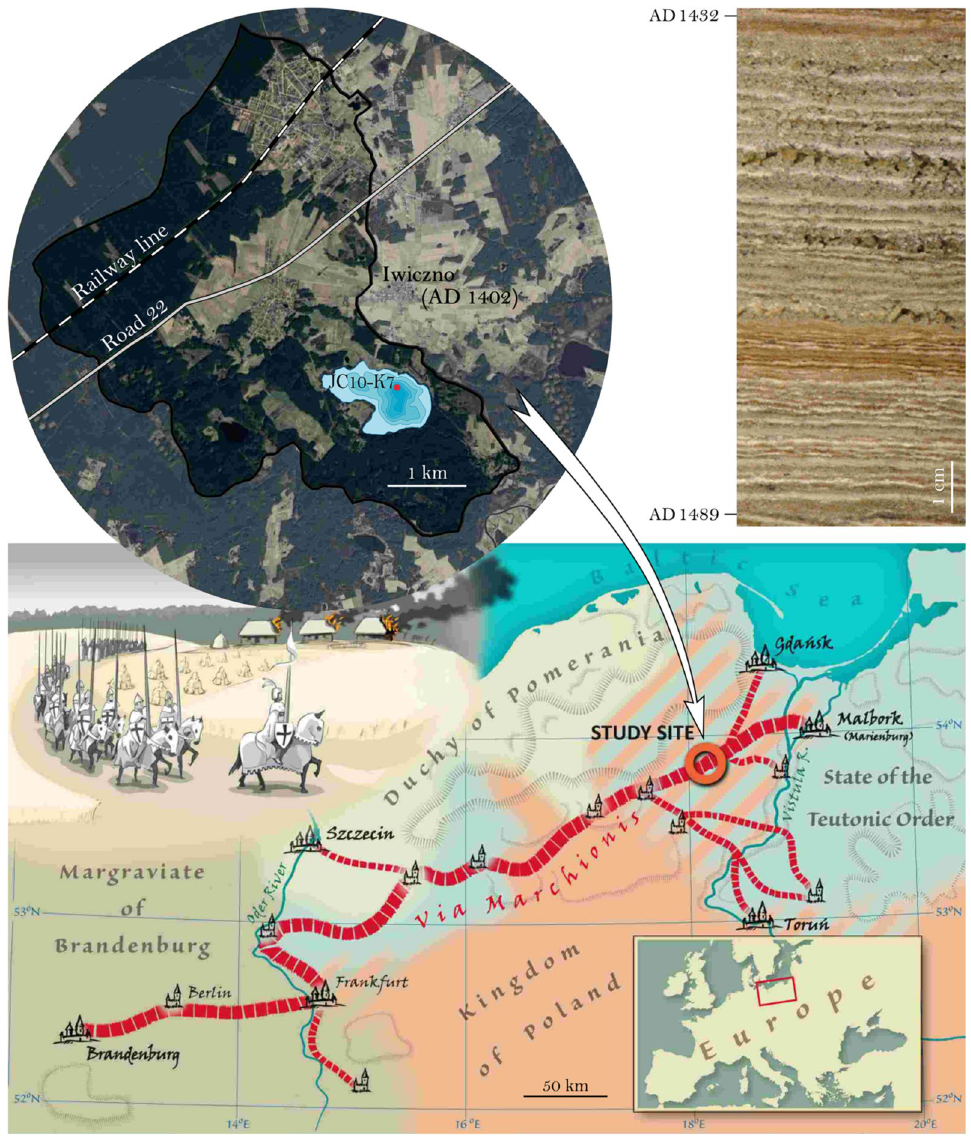
Figure 1. Present day location of Lake Czechowskie with coring site and catchment and modern road and railroad locations (upper left, image source: air image provided by Head Office of Geodesy and Cartography, Warsaw, Poland). Upper right: core photograph showing the varved sediment interval from AD 1489 – 1432. Bottom: Course of the via Marchionis and location of the lake (red circle) on a map which provide special to this manuscript by Piotr